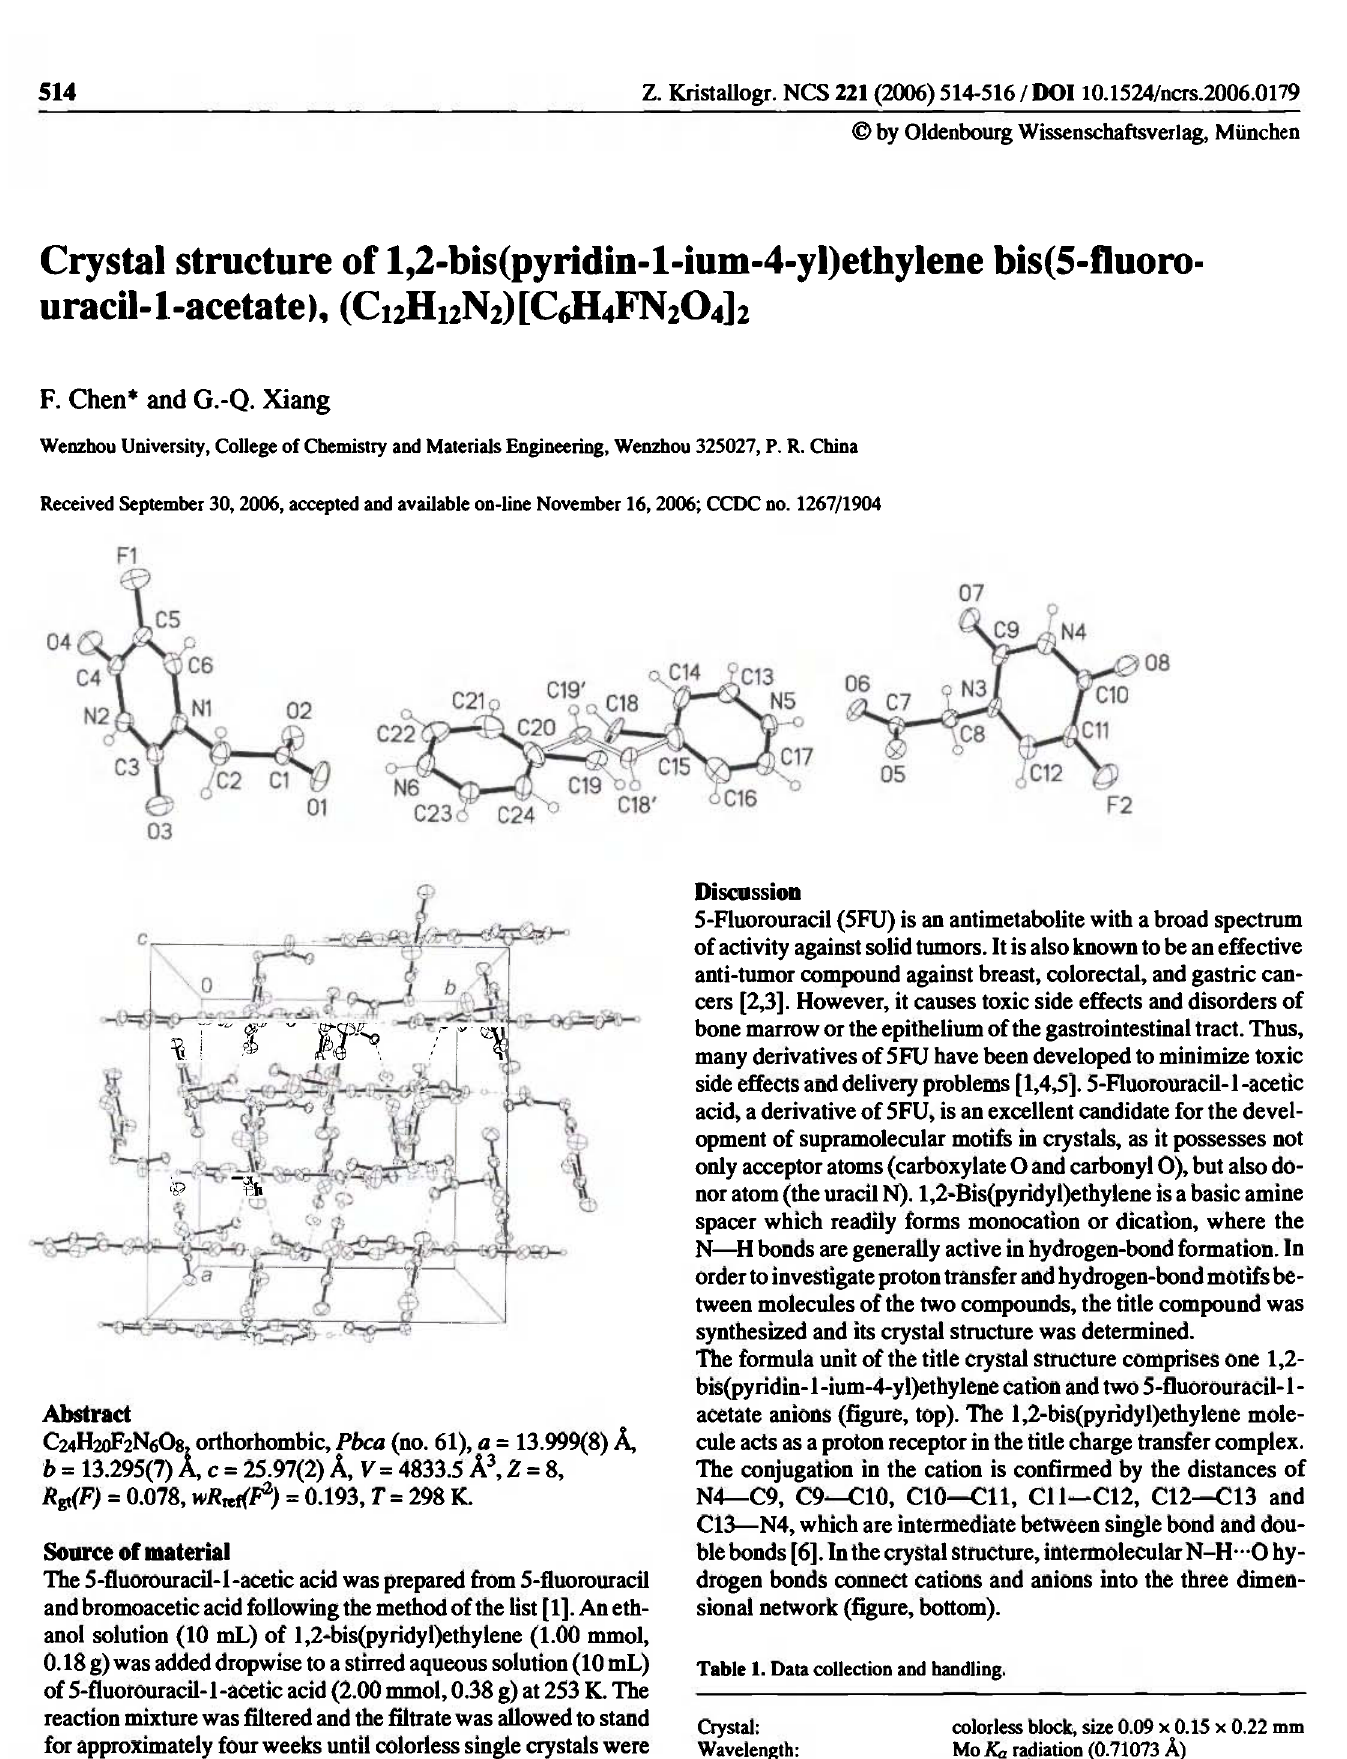
Table 1. Data collection and